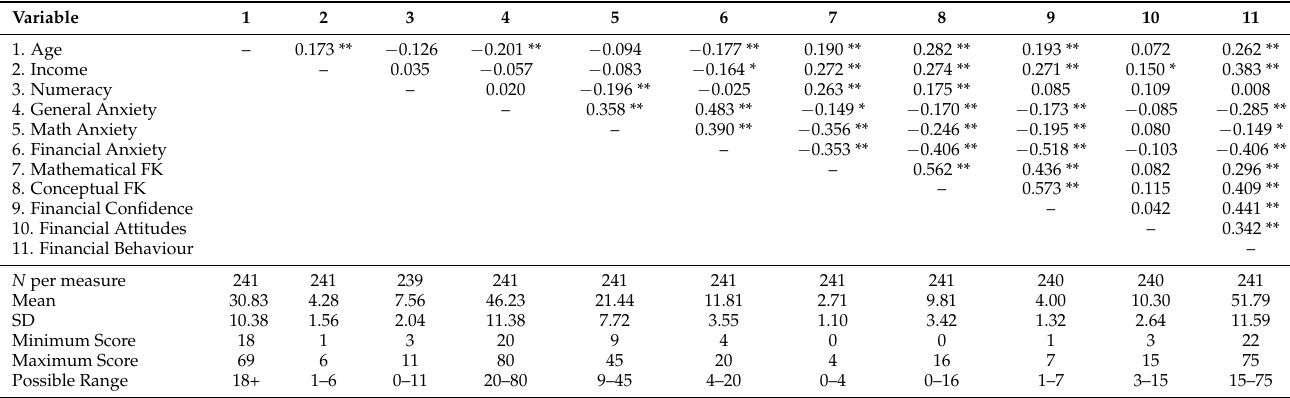
Table 1. Correlations and Descriptive Statistics for All